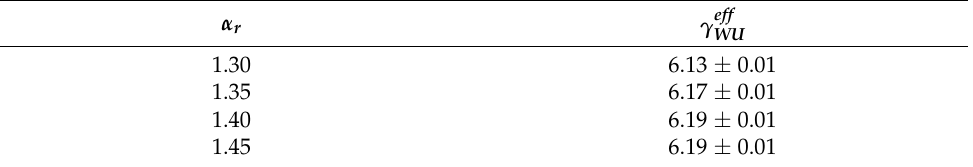
Figure 7. Plots of the attempts at employing the values of the density scaling γ ef f found from the analysis of the WU correlation as its slope coefficient in the implementation of the density scaling of translational relaxation times τ collected in the supercooled liquid state in the GB model. In the separate panels, there are the cases shown for the different anisotropy aspect ratios α r : ( a ) 1.30, ( b ) 1.35, ( c ) 1.40, and ( d ) 1.45, respectively. In the insets to the subsequent panels, the tested isochoric WU correlations are represented at volumes (1.27, 1.32, 1.37), (1.32, 1.37, 1.42), (1.37, 1.42, 1.47), and (1.42, 1.47, 1.52) for α r = 1.30, 1.35, 1.40, and 1.45, respectively. The estimated values of γ ef f used in the scaling plots are listed in Table 3. Table 3. The effective values of the density scaling exponent γ ef f WU evaluated as mean values of slope coefficients of the linear isochoric correlations presented in the insets in the panels of Figure 7 between the instantaneous values of the total system virial <W> and the total system potential energy <U> for all examined anisotropy aspect ratios α r . The determination errors of the effective values of the density scaling exponent γ ef f WU are the standard deviation errors of the mean value of the slope coefficient values of the isochoric linear dependences shown in the insets in the panels of Figure 7 for a given anisotropy aspect ratio.